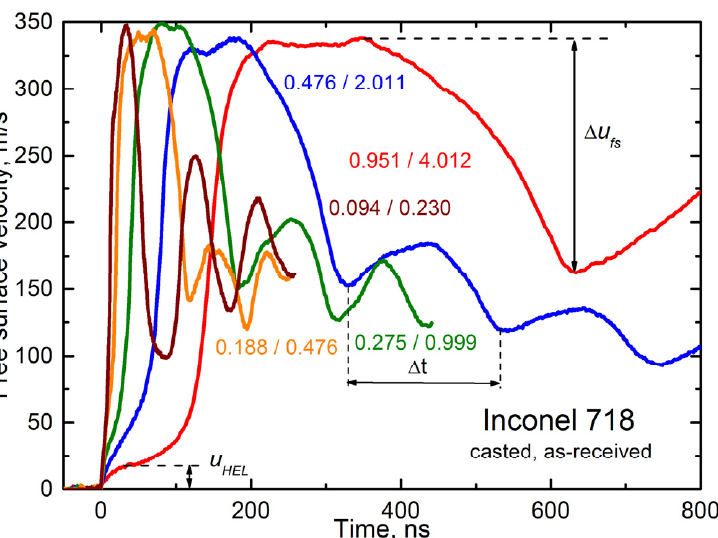
Figure 3. The velocity histories of the cast Inconel 718 alloy samples in the as-received state. The thicknesses of the impactors and the samples are indicated for each profile by the same color. The experimental conditions are shown in Table